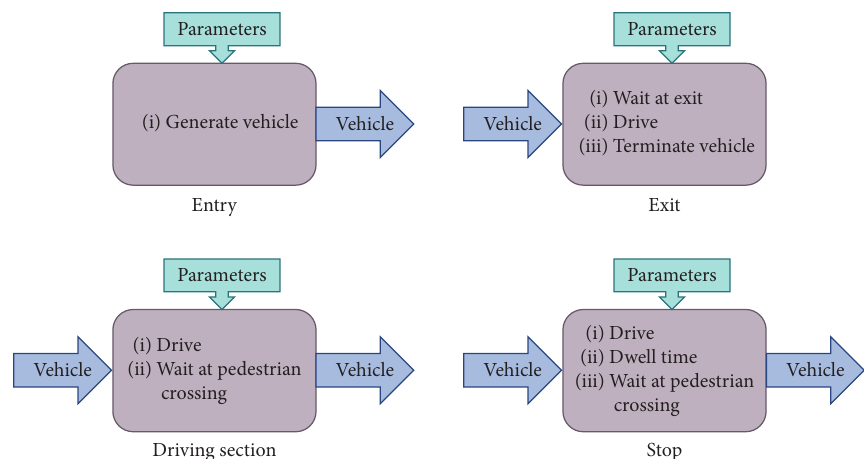
Figure 5: The four types of modules and their main events and activities.